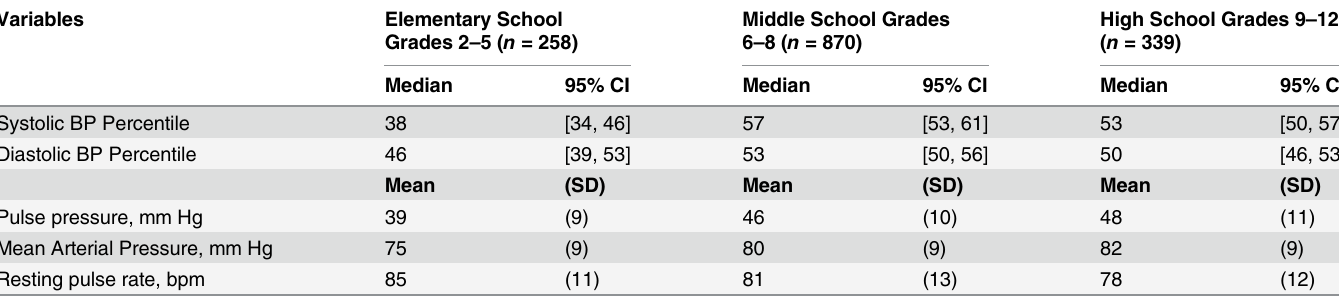
Table 3. Resting Blood Pressure Indices and Pulse Rate of Urban School Students by Grade Level.